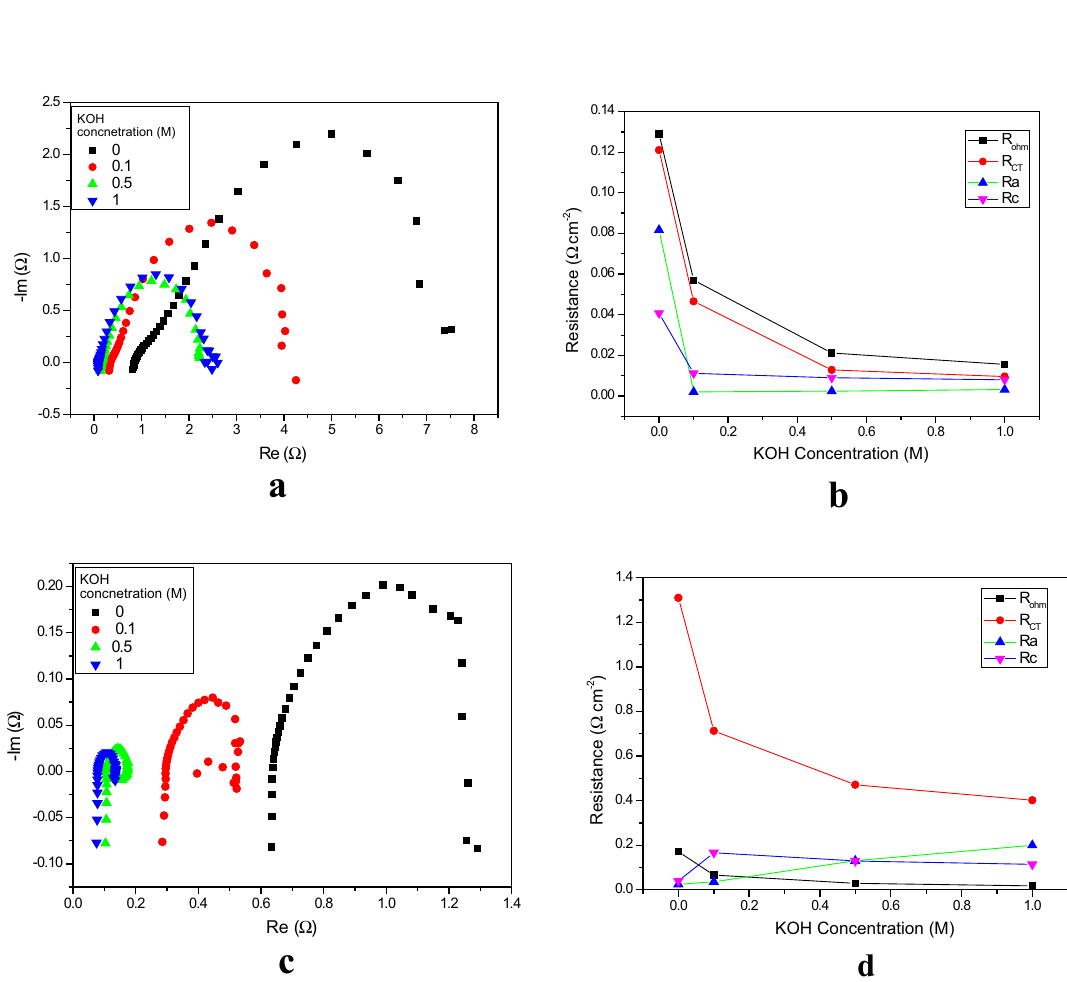
Figure 8. (a) Figure 7a Nyquist plots of EIS measurements (from 100 kHz to 1 MHz) for the function of liquid electrolyte concentration at 1.5 V. ( b) Variation in the relevant electrochemical resistances as a function of concentration at 1.5 V. ( c) Nyquist plots of the EIS measurements (from 100 kHz to 1 MHz) from the function of liquid electrolyte concertation at 1.9 V. ( d) Variation in the relevant electrochemical resistances as a function of electrolyte concentration at 1.9